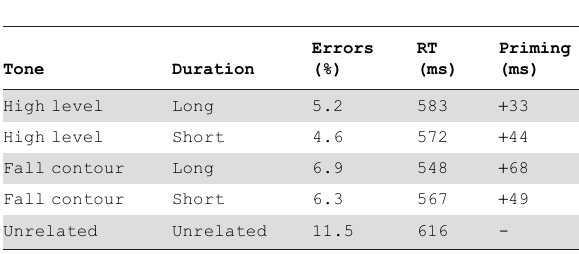
Table 3. Response latencies and error percentages from the priming experiment.